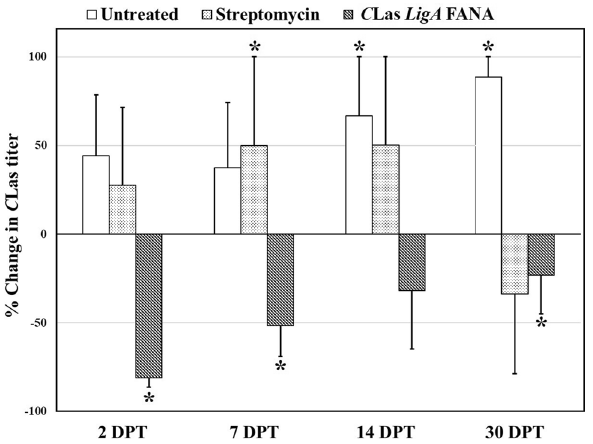
Figure 7. Effect of FANA ASO on C Las titer in Citrus plants. Treatment effect was expressed as percentage change in C Las titer [(mean titer after treatment − mean titer prior to treatment)/mean titer prior to treatment] × 100. Means and standard errors are represented by bars and whiskers, respectively. Bars followed by an asterisk indicates significant change (increase or decrease) in C Las copy number as compared to that before treatment (DPT: days post treatment) (TIBCO Statistica, v. 13.3.0: https ://www.tibco .com/produ cts/data-scien